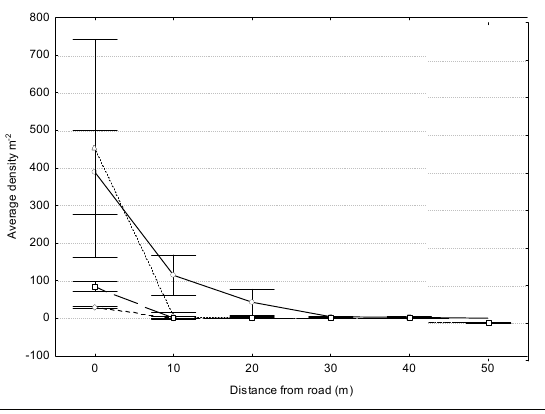
Figure 4 Average snail densities (m -2 ) of Theba pisana (mean ± SD) along 50 m transects extending perpendicular to the road at four sites within the WCNP (Site 1: □, Site 2: ∆, Site 3: ◊, Site 4: ○)